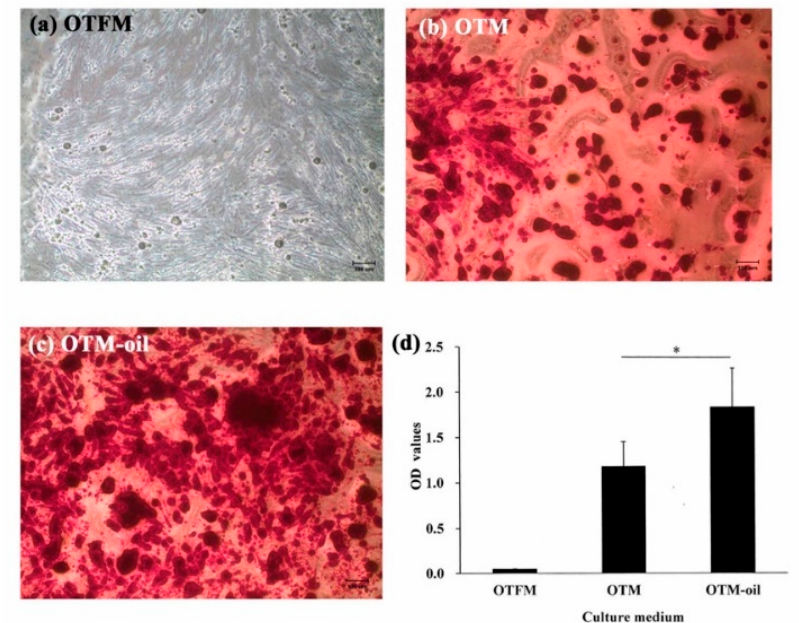
Figure 4. Osteogenic differentiation capacities of DPSCs as assessed by Alizarin red S staining after 14-day culture period. ( a ) No mineralized nodule deposition is observed when the DPSCs are cultured in general medium. ( b ) Following osteogenic medium induction, observable mineralized nodule deposition occurs. ( c ) Following co-culturing with osteogenic medium and S. mukorossi seed oil, the DPSCs secrete more abundant mineralized nodules. ( d ) Quantification of the Alizarin red S staining results shows a significant difference between the OTM and OTM-oil groups (* p < 0.05). (Note OTFM: osteogenesis induction-free medium; OTM: osteogenesis induction medium; and OTM-oil: osteogenesis induction medium with S. mukorossi seed oil.). Scale bars for a , b and c denote 100 µm.